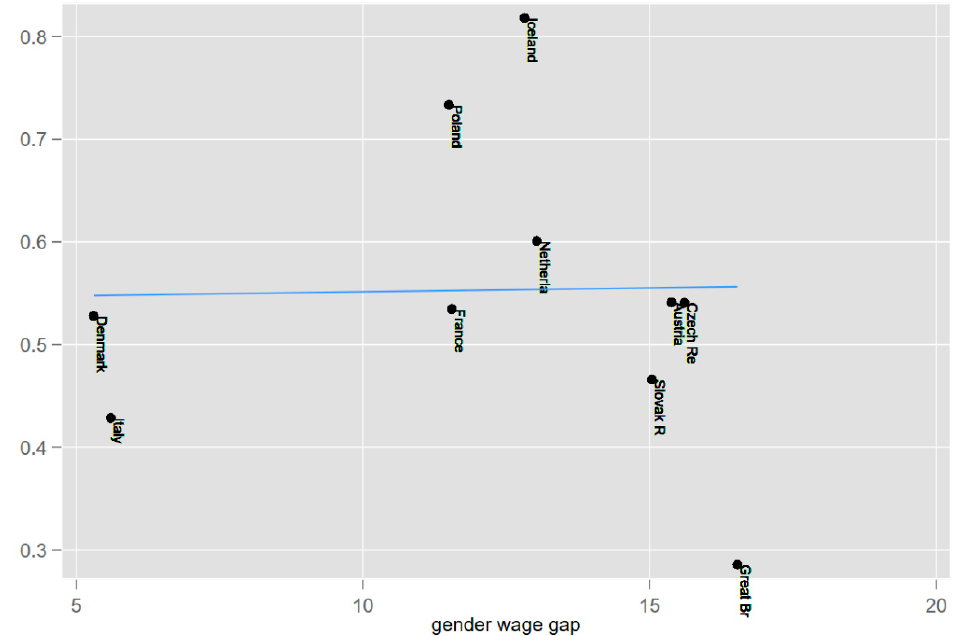
Figure A1. Scatterplot on the relationship of gender wage gap and the gender gap in far-right voting. Table A5. Mixed-effects logit regression to explain the gender gap in far-right orientation with region as control.